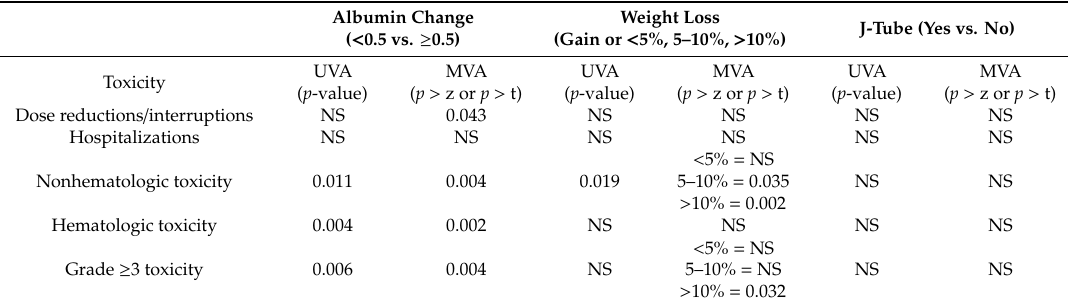
Table 4. Associations between nutritional markers and toxicity.